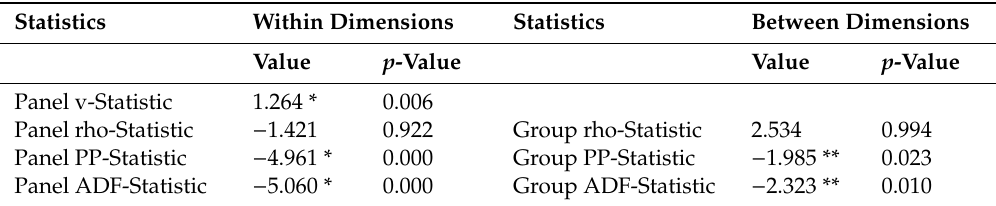
Table 4. Residual cointegration test.